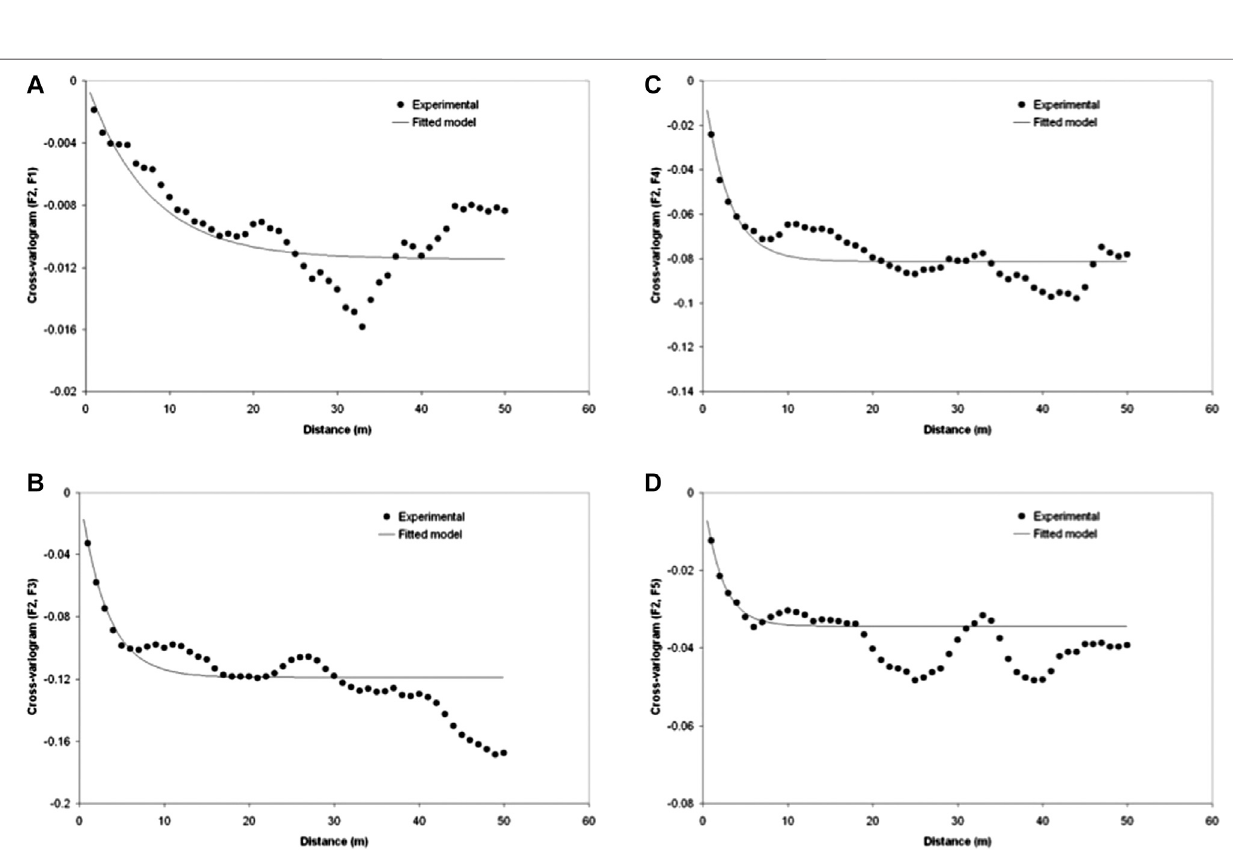
tted by taking account of the experimental proportions and using weighted least squares to fi t an exponential model with no